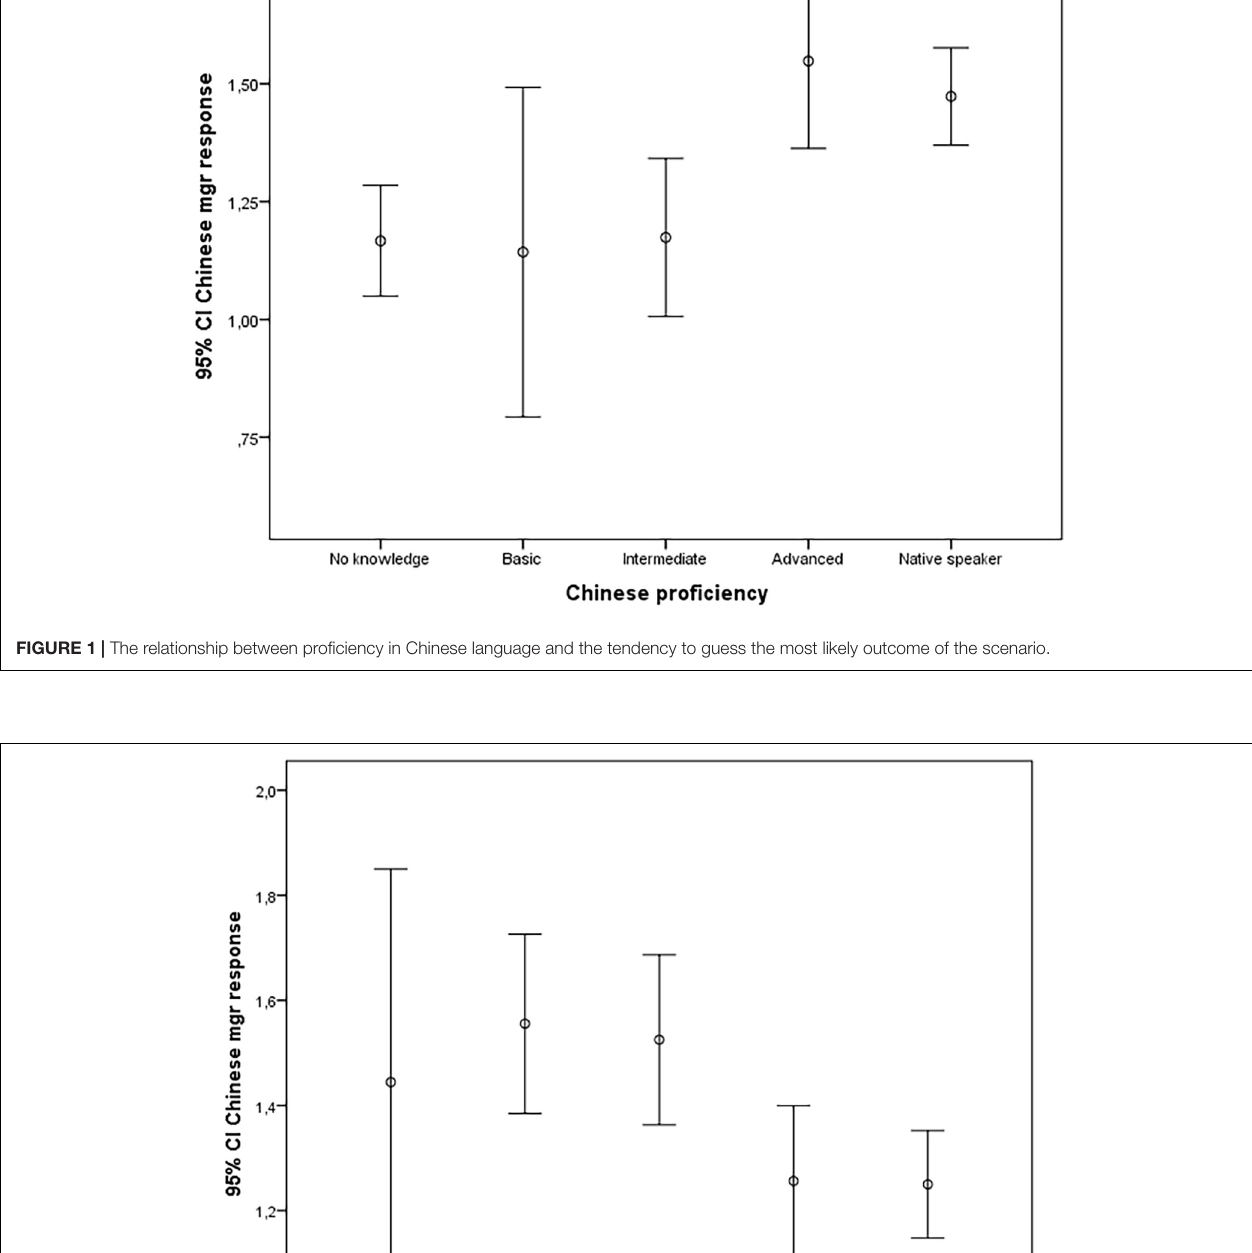
Frontiers in Psychology |